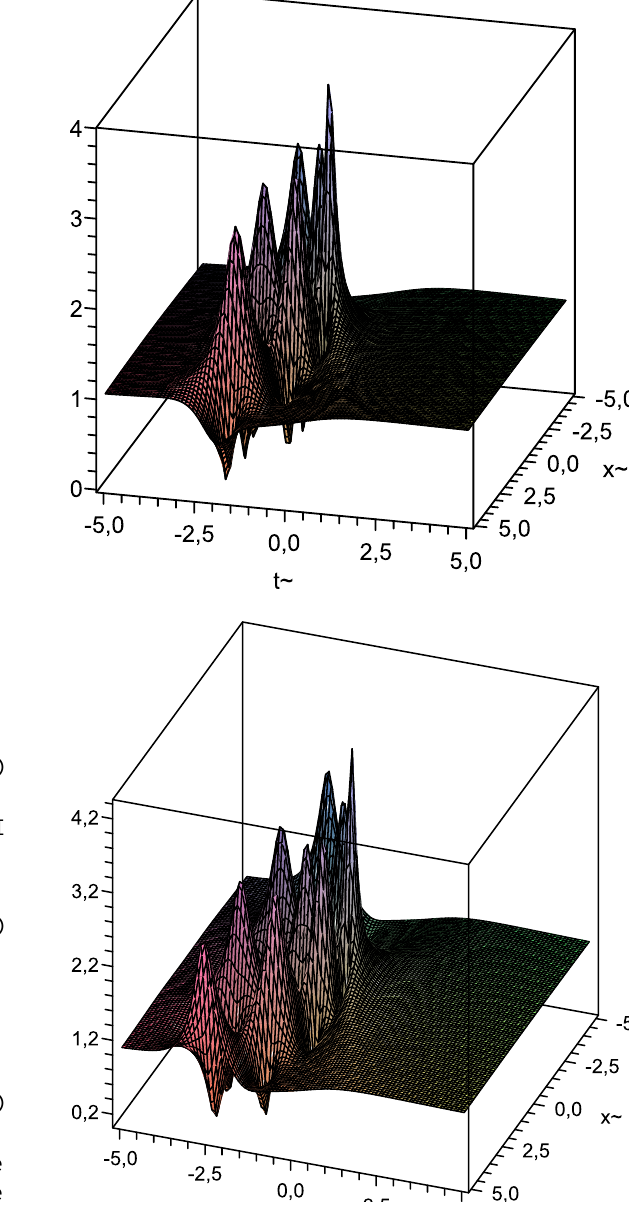
Fig. 4. Plot of | v(x,t) | with vanishing phases for n = 3 at the top and n = 4 at the